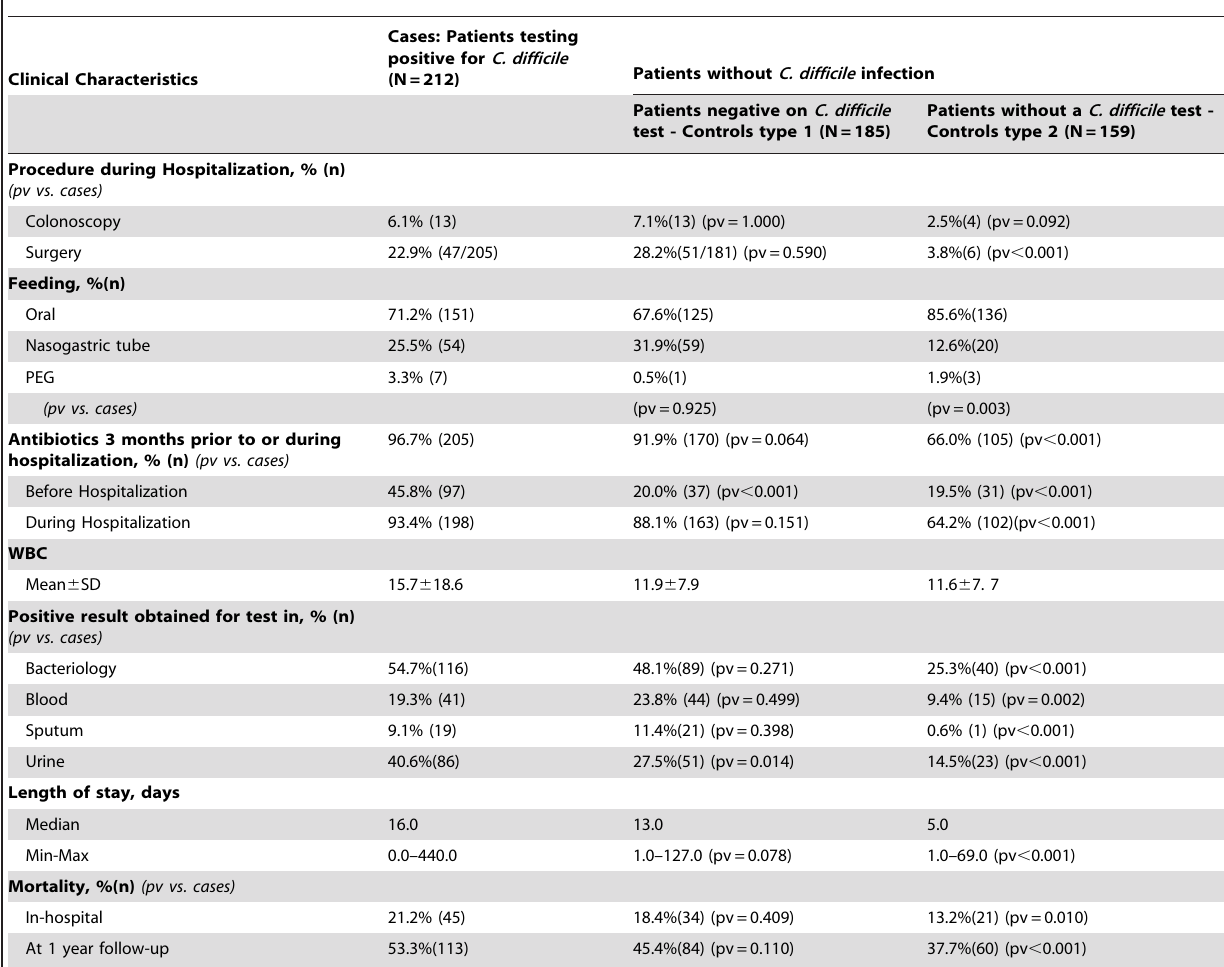
Table 2. Clinical Characteristics of the study population during hospitalization, by study groups.